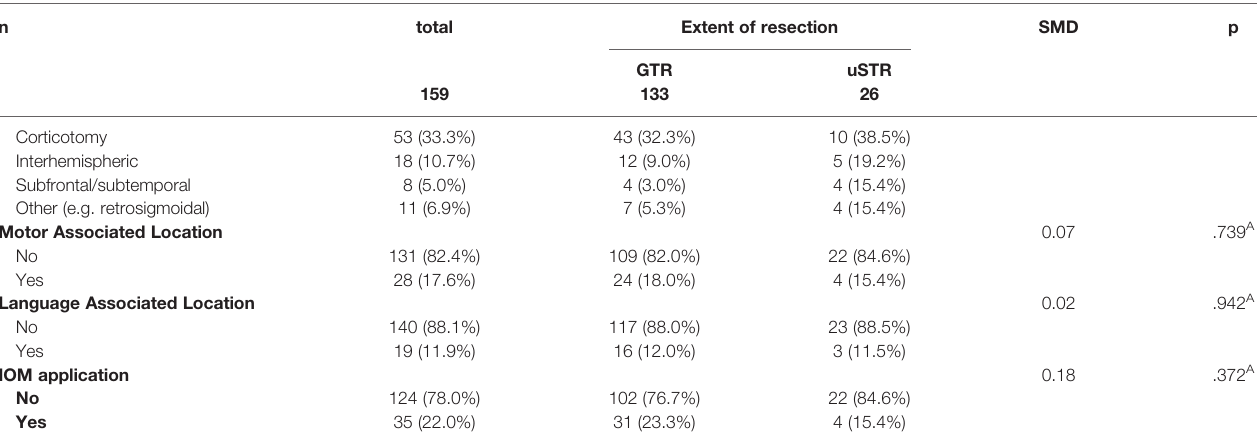
Table 2 analyzes the relationship of metastases ’ characteristics to the extent of resection. For this analysis, intended subtotal resections (n = 6) were excluded to avoid biasing the risk assessmentforunplannedresections.Thetumor-cortexangleswereonlycalculatedforsubcorticalmetastases(n=95)andgroupedaccordingtopercentilesdistribution. A